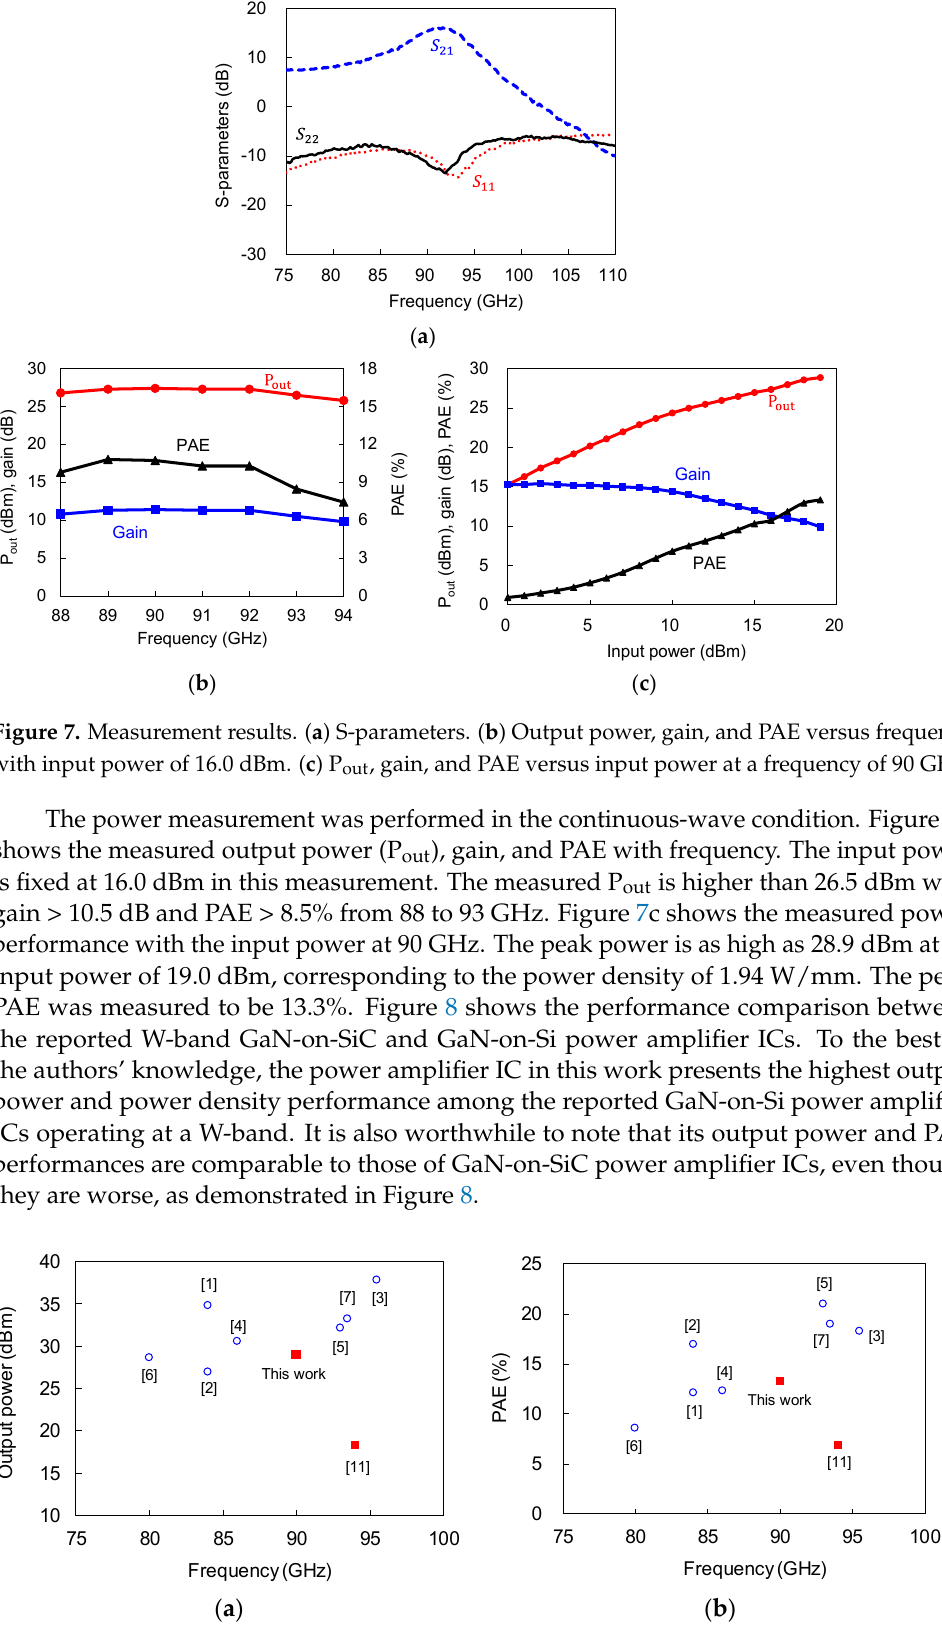
Figure 8. Comparison of the reported W-band GaN power amplifier ICs (circles: GaN-on-SiC, squares: GaN-on-Si). ( a ) Output power versus frequency. ( b ) PAE versus frequency.